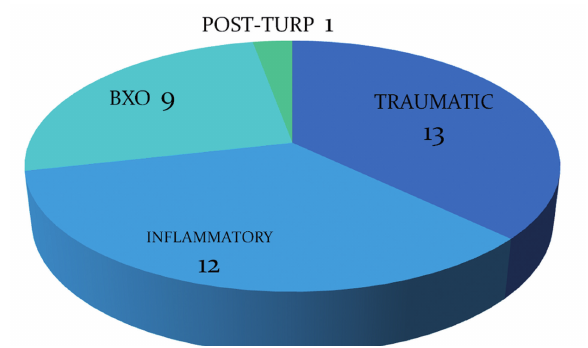
Figure 1 - Etiology of